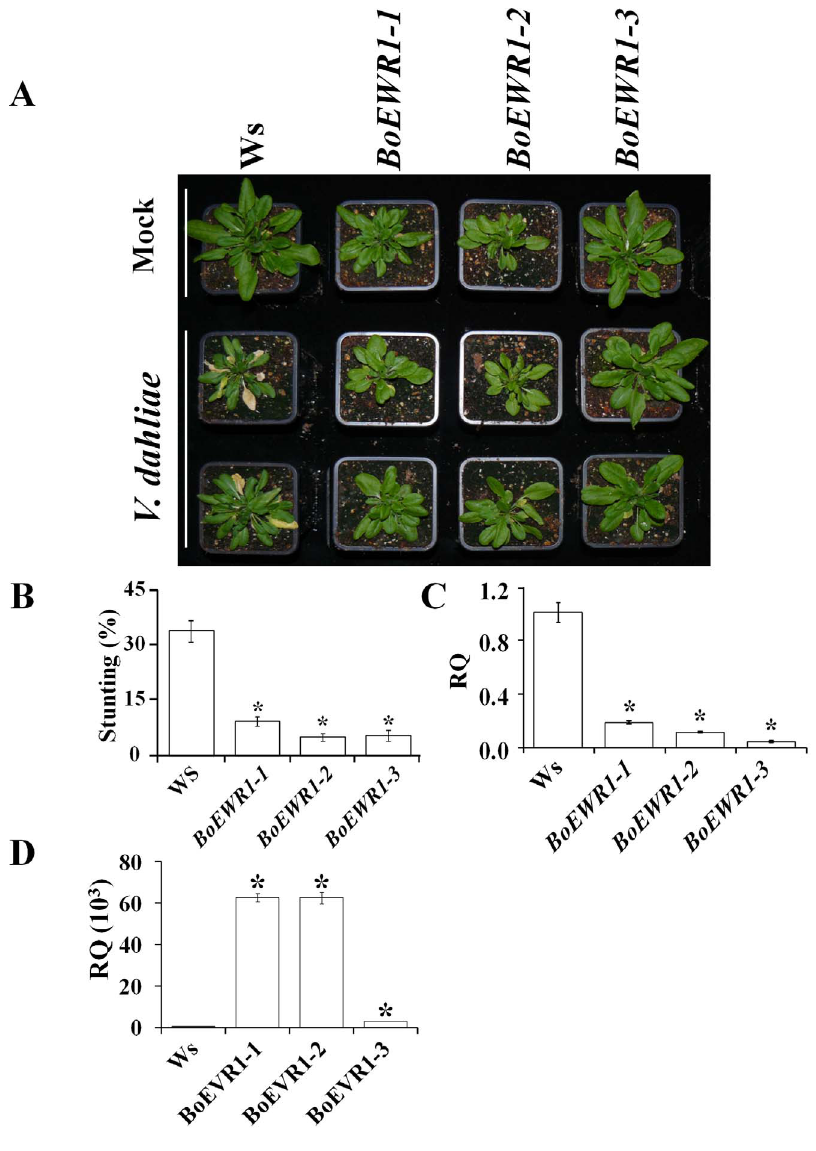
Figure 7. BoEWR1 over-expression enhances Arabidopsis resistance to Verticillium wilt. (A). Typical disease symptoms caused by V. dahliae on the wild-type (WS) and three independent BoEWR1 over-expressing plants (BoEWR1-1, BoEWR1-2 and BoEWR1-3) at 21 days post inoculation (dpi). The experiment was repeated at least three times and representative of the three independent biological replications is shown. (B) Verticillium -induced stunting of wild-type (WS), three independent BoEWR1 over-expressing plants (BoEWR1-1, BoEWR1-2 and BoEWR1-3) at 21 dpi. Rosette diameters of inoculated plants were compared with those of mock-inoculated plants. The bars represent averages of three independent experiments with standard deviation and asterisks indicate significant differences (Dunnett t-test at P=0.05 ). (C) Relative quantification (RQ) by real- time PCR of Verticillium colonization by comparing levels of the V. dahliae internal transcribed spacer (ITS) region of the ribosomal DNA (as measure for fungal biomass) relative to levels of the large subunit of the Arabidopsis RubisCo gene (for equilibration) at 21 dpi. Bars represent averages with standard deviation of four technical replicates. A representative of three independent experiments is shown. (D) Relative quantification (RQ) of EWR1 transcription in wild-type (WS) and three independent BoEWR1 over-expressing plants (BoEWR1-1 and BoEWR1-2, and BoEWR1-3). Bars represent averages with standard deviation of three biological replicates doi:10.1371/journal.pone.0088230.g007 resistance in the A1 mutant [23]. Here, we cloned the activation- tag insertion site in the A2 mutant that showed enhanced resistance not only to Verticillium spp., but also to R. solanacearum . Among the 11 genes found within a 31 Kb window spanning the activation tag insertion site, four genes showed induced expression in the A2 mutant, of which At3g13437 ( EWR1 ) showed the strongest over-expression when compared to wild-type plants.